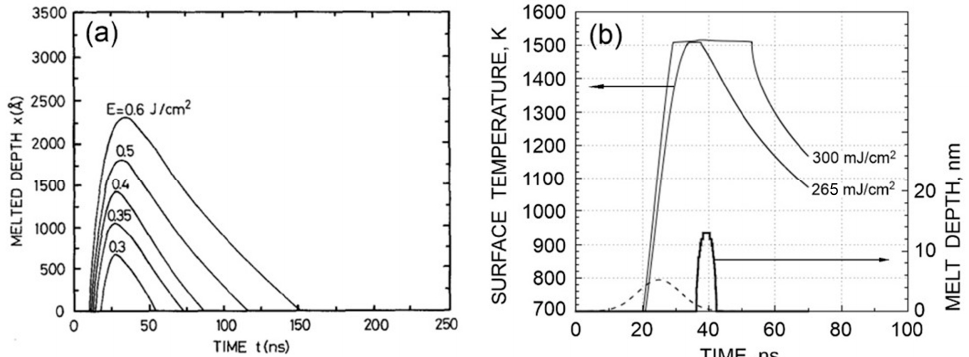
Figure 2. Comparison of the results obtained by modelling in Ref. [12] and in this work for GaAs irradiated by 694-nm, 15-ns laser pulses. ( a ) The depth of molten material as a function of time for several laser fluences (reprinted with permission from Ref. [12]). ( b ) The results of the present modeling for laser fluences of 265 mJ/cm 2 (corresponding to the defined melting threshold) and 300 mJ/cm 2 . The temporal evolution of the melt depth at 300 mJ/cm 2 is also given to compare with Ref. [12]. The laser pulse is shown by the dashed line.